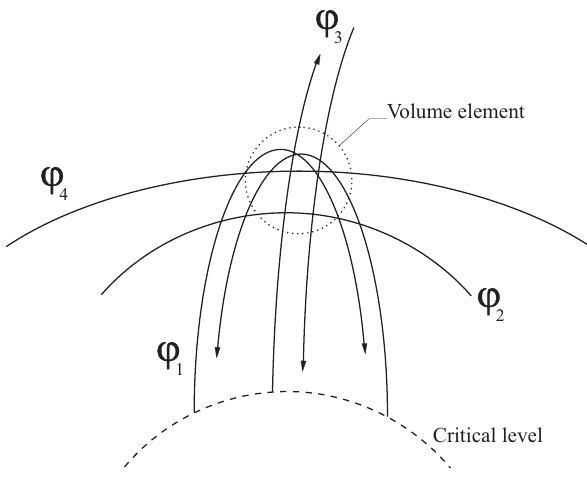
Fig. 12. Vertical distribution of the mean free path for several ther- mopause temperatures. The triangles give the altitude where the mean free path is equal to the atmospheric scale height.